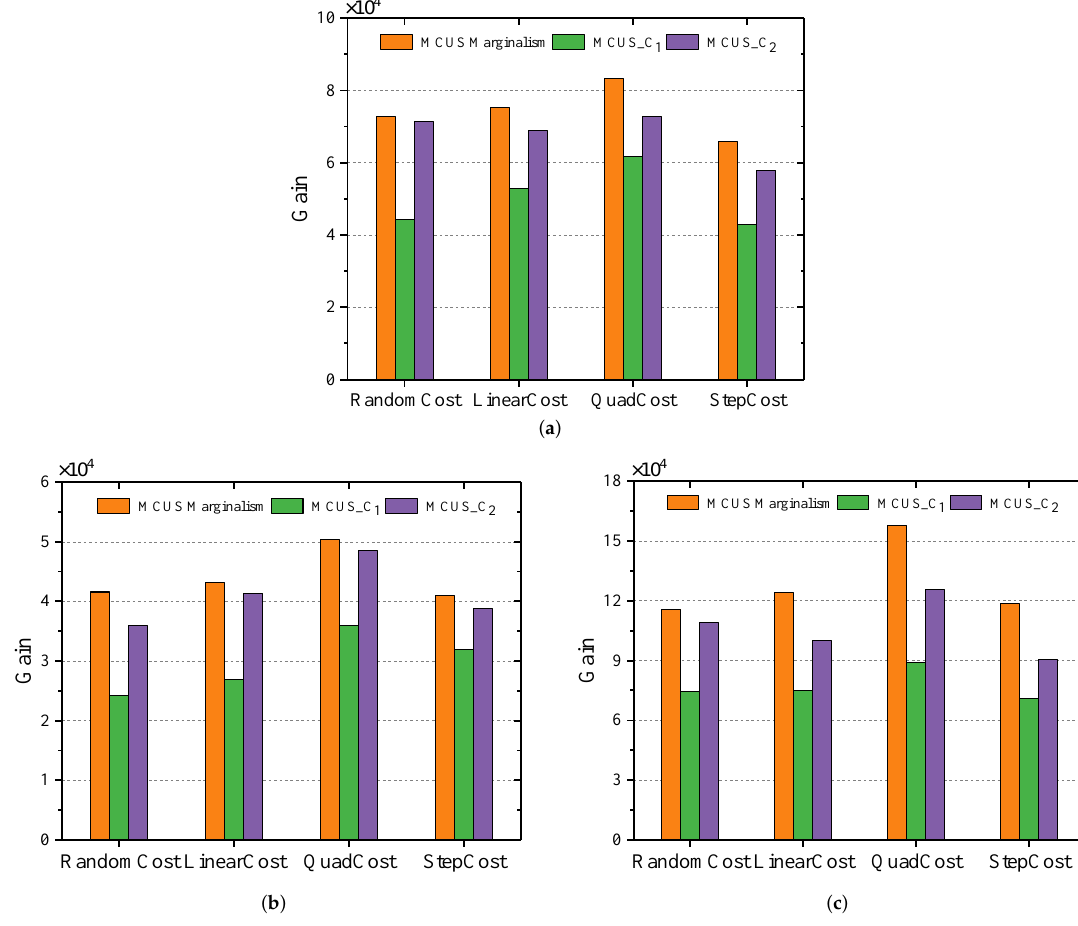
Figure 3. Comparison of three selection schemes. ( a ) LinearGain; ( b ) QuadGain; ( c )